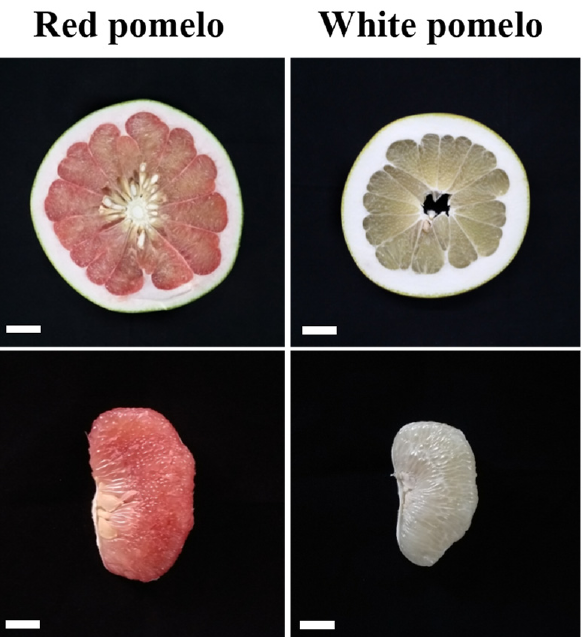
Figure 1. Phenotype of two pomelo cultivars: white- ( Citrus maxima (Burm.) Osbeck) and red-sarcocarp pomelos ( Citrus maxima Merr. var. Tubtim Siam). Bars indicate 3 cm.